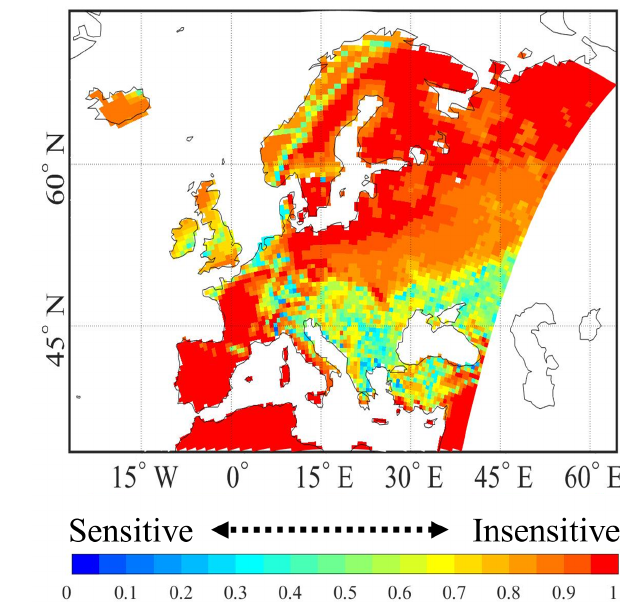
Figure 12. Comparison of modification cases with CTRL from no modification case as CTRL. Red colors indicate that the coupling classification is sensitive to modifications in temperature and mois- ture, and greenish colors indicate that the coupling classification is insensitive to modifications in temperature and